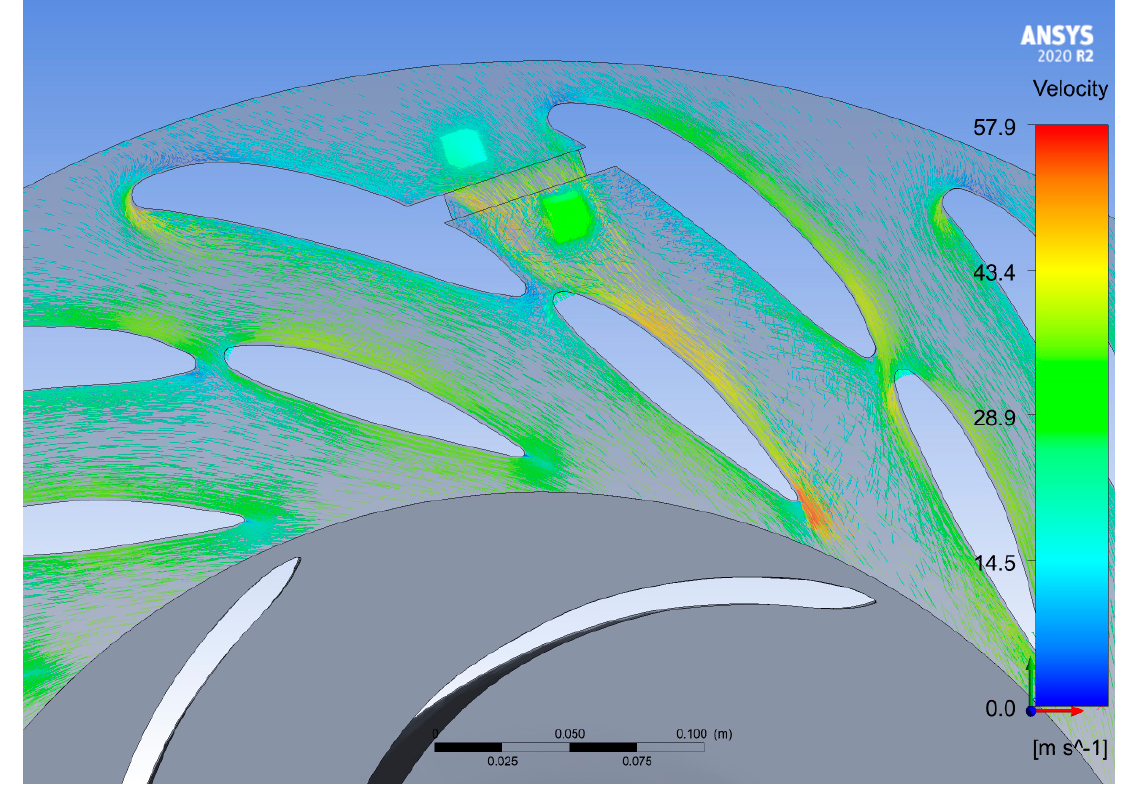
Figure 10. Velocity vector plot near the blockage for a 50% obstructed distributor.